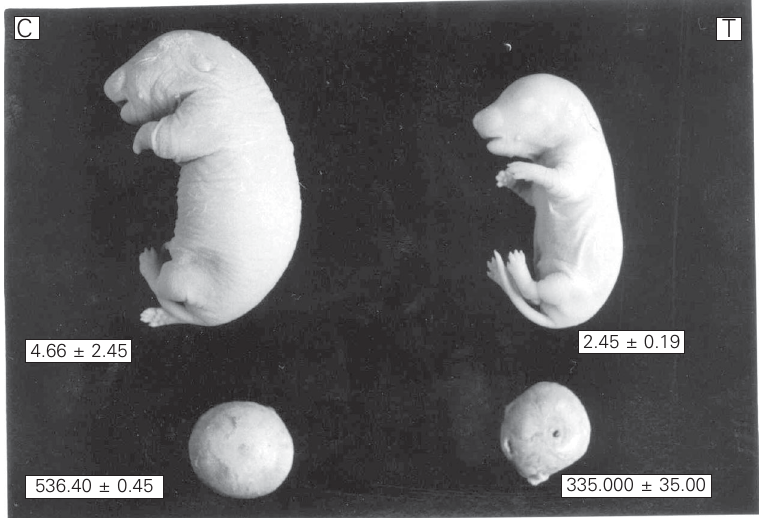
Figure 1. Pups born to mothers of the control (C) and trained (T) groups. Fetal (g) and placental (mg) weights are reported as means ± SD for 7 pups in each